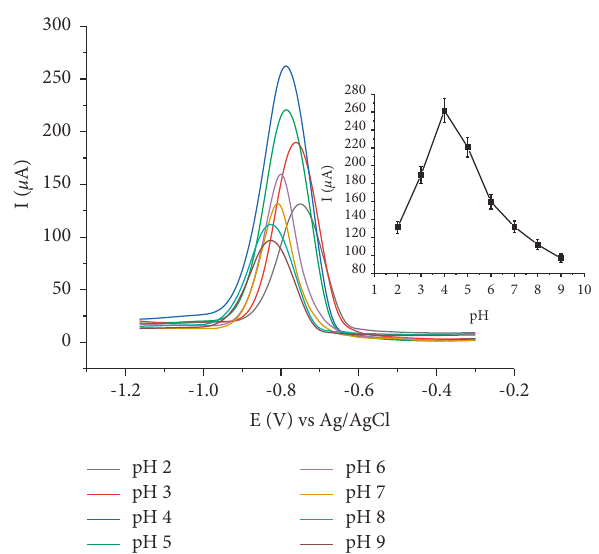
Figure 10: Effect of pH of Britton Robinson (B-R) solution on the peak current of Cd(II); Cd(II) concentration: 100nM. Accumu- lation time: 270s; accumulation potential − 1.0V; amplitude: 100mV, frequency: 80Hz; and step potential 6mV.